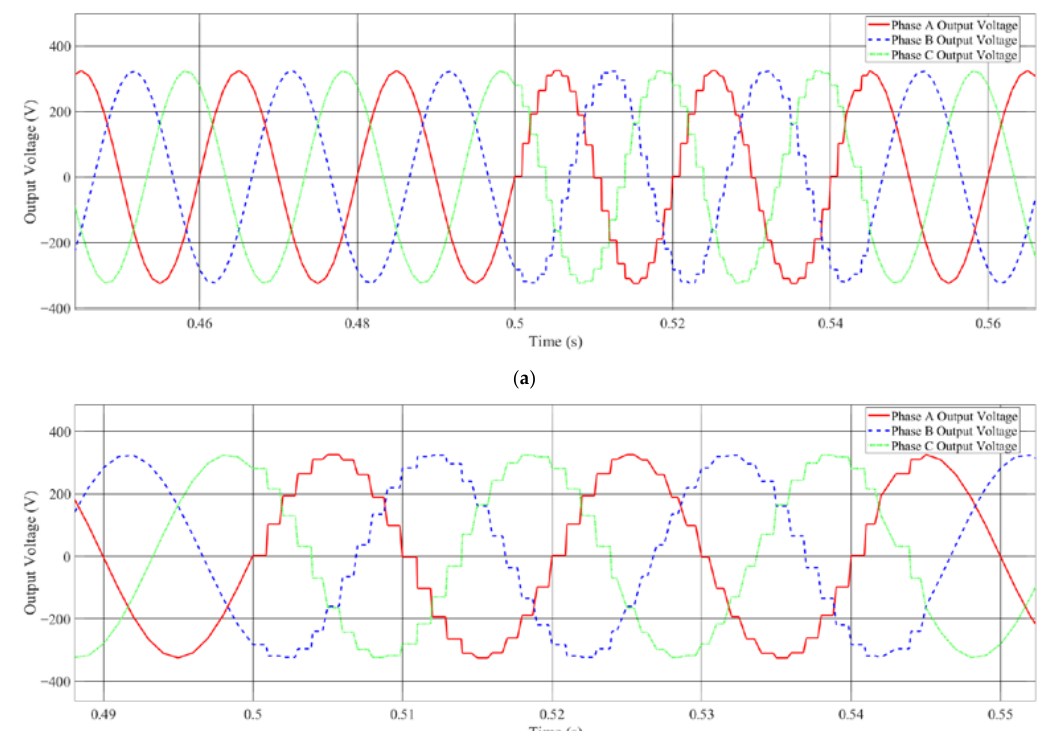
Commented [M27]: Please replace the hyphens (- ) with mi-